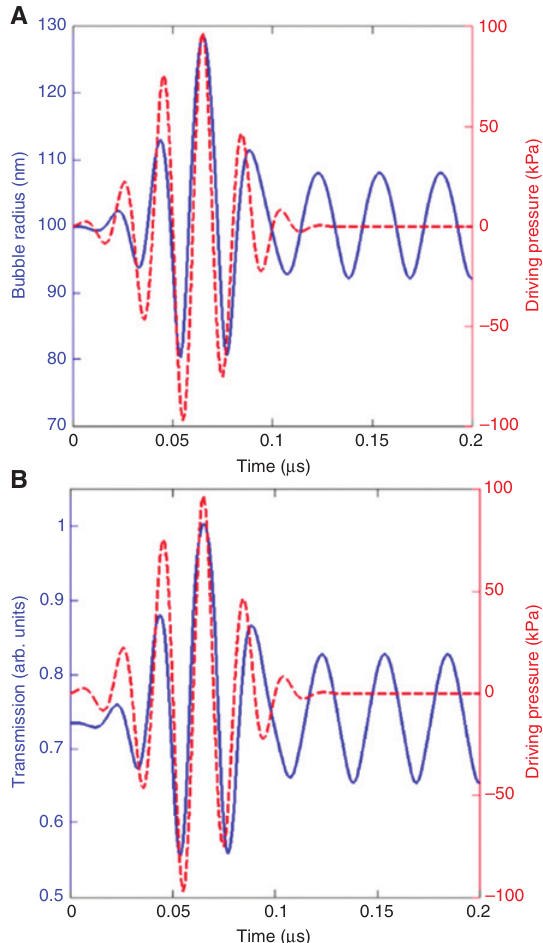
Figure 5: Opto-acoustic response of an oscillating gas bubble. (A) Theoretical response of a 100-nm-radius air bubble in water (blue solid curve) to the applied acoustic pressure (red dashed curve). (B) The acoustic response of the bubble becomes imprinted onto the intensity of light that illuminates the bubble. Here, the bubble is located in and the light is transmitted through a 300-nm-wide circular, water-filled hole in a 400-nm-thick